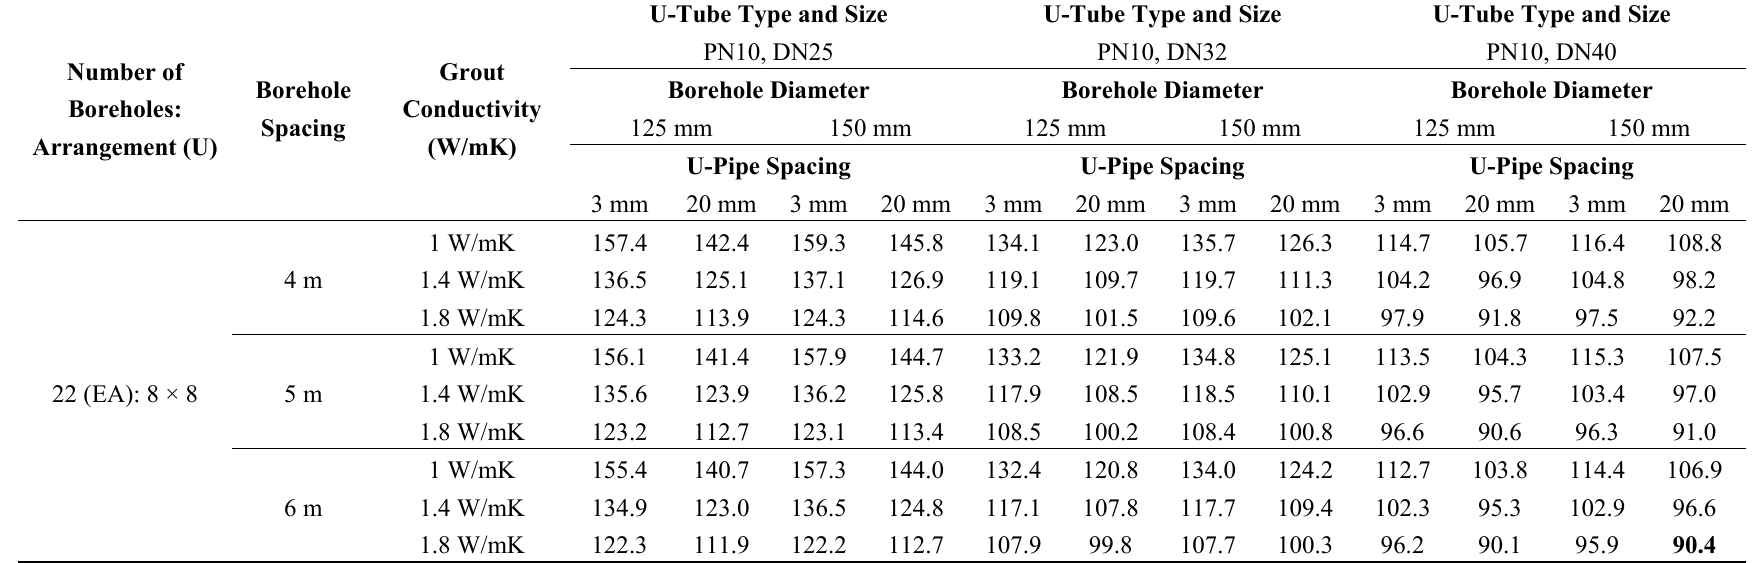
Table A1. Scenarios (length of borehole) of GHE considering EWT (30 °C) and characteristics of